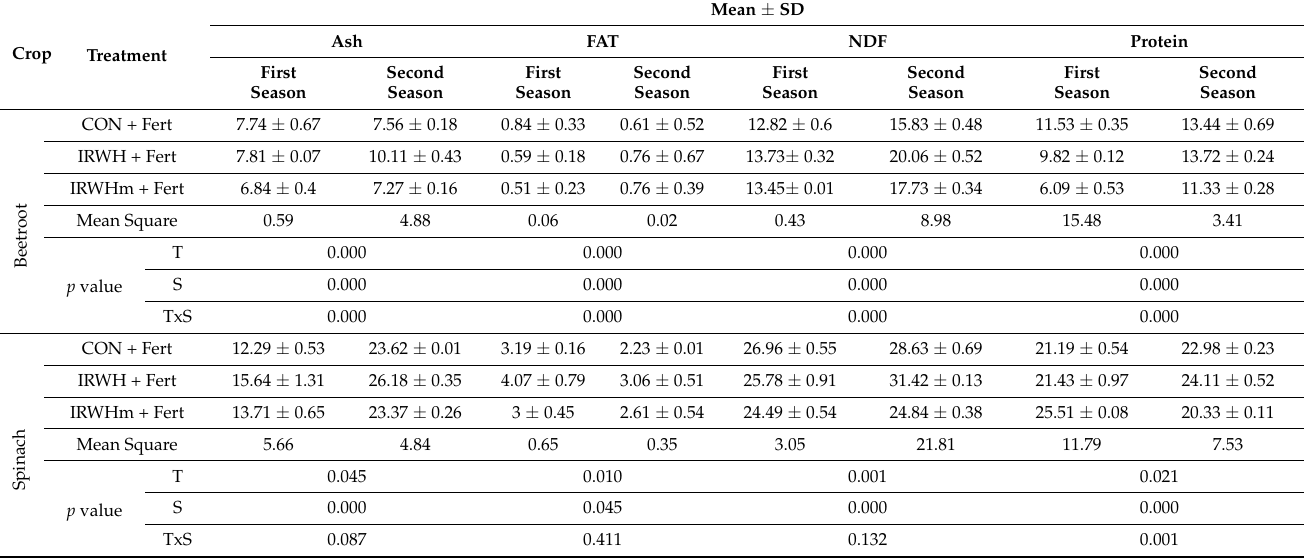
Table 4. Effect of season, agronomic treatments and water-use technology on the proximate